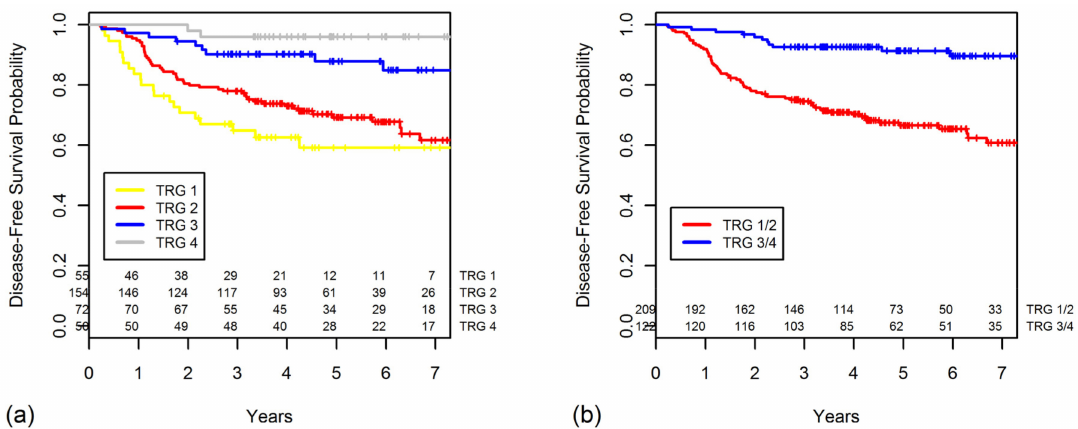
Figure 1. Disease-free survival (DFS) curves are shown for categories of ( a ) tumor gregression grade (TRG) and ( b ) grouped TRG.